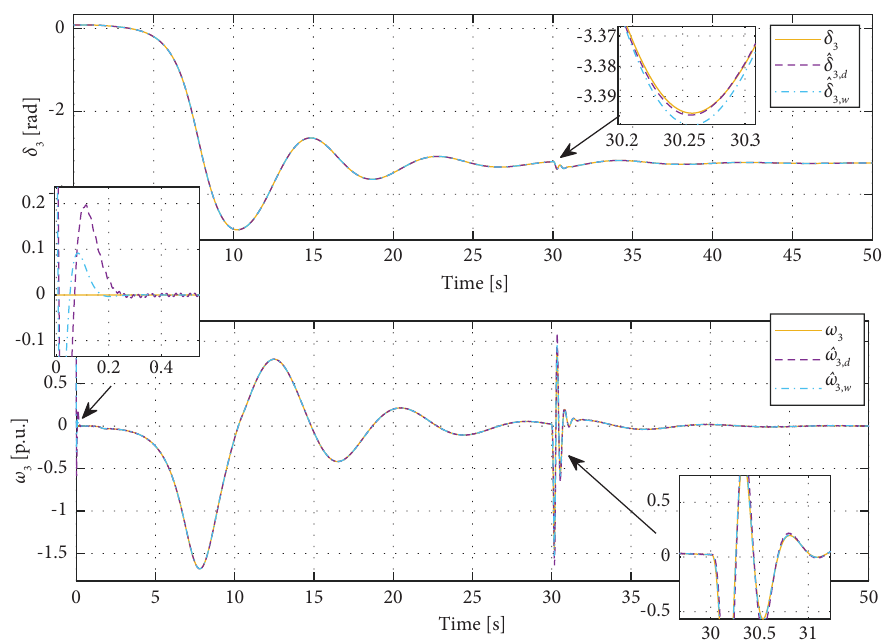
Figure 6: Comparison between the L-D GE estimators: load angle and relative speed of generator three.